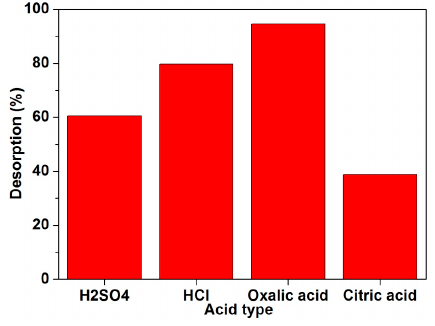
Figure 9. The effects of acid type on iron removal from saturated Rexp-501, 298 K.